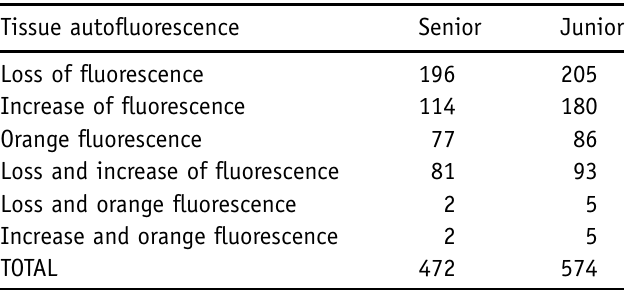
Table II. Tissue auto fl uorescence characteristics of all lesions observed by senior and junior operators.